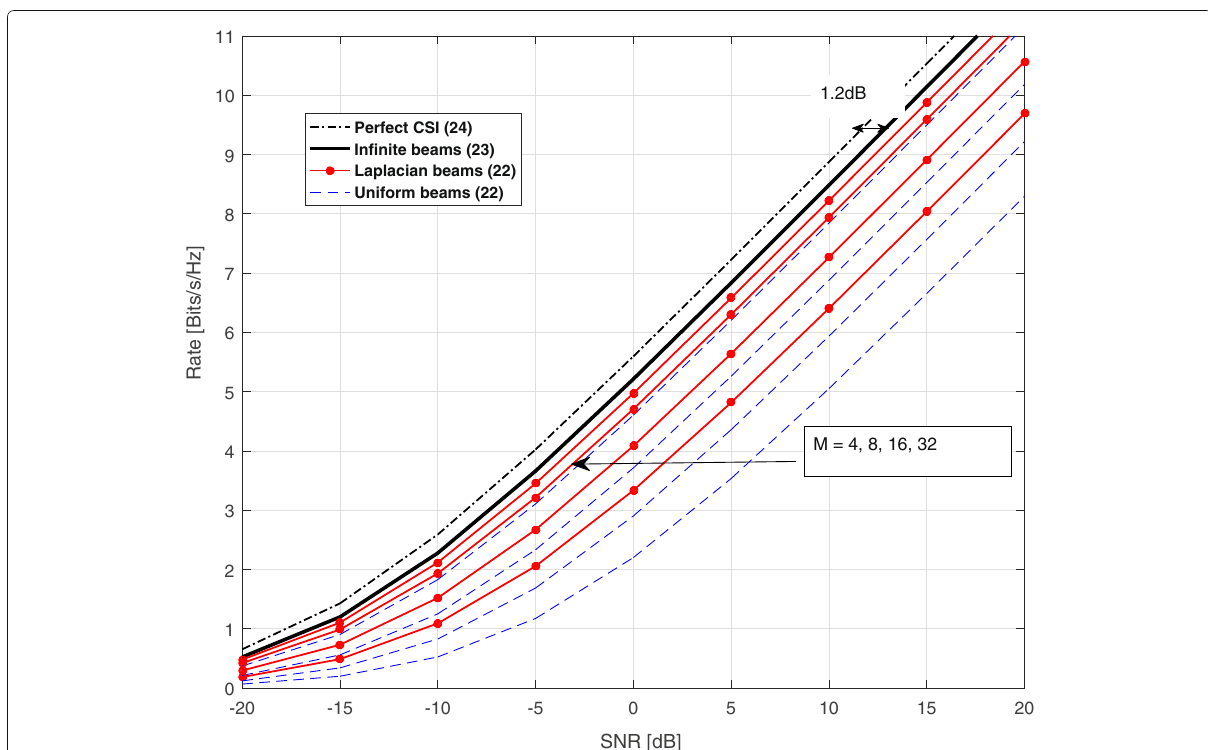
Fig. 4 Spectral efficiency achieved by Laplacian beam codebooks compared to uniform beam codebooks for various numbers of codebook sizes M = { 4,8,16,32 } and N p = 2